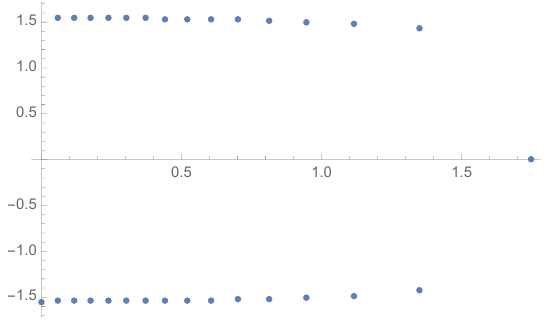
Figure 11 . Bethe roots for L = 32. A solution to the BAE in the n = 2 sector with (cid:13) = (cid:25)